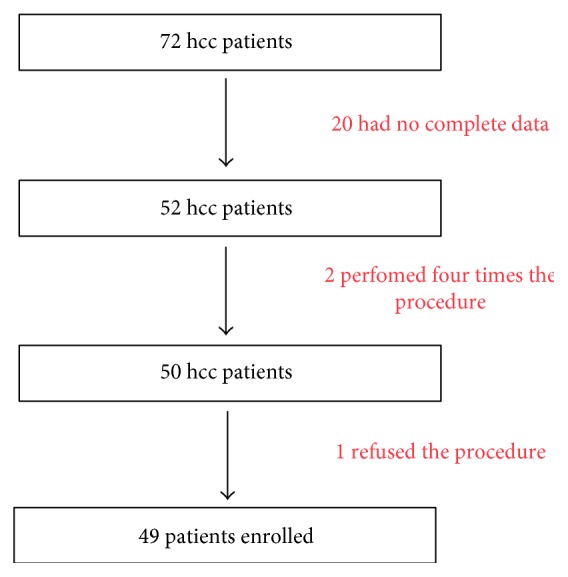
Flow chart of the patients enrolled.